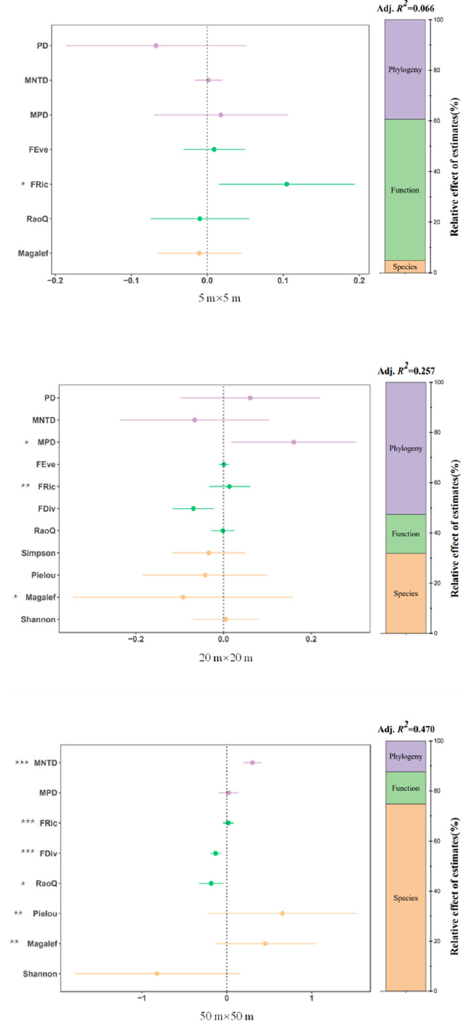
Figure 4. Relationship between plant diversity and ecosystem multifunction at different scales. Note: *, ** and *** represent p < 0.05, p < 0.01 and p <